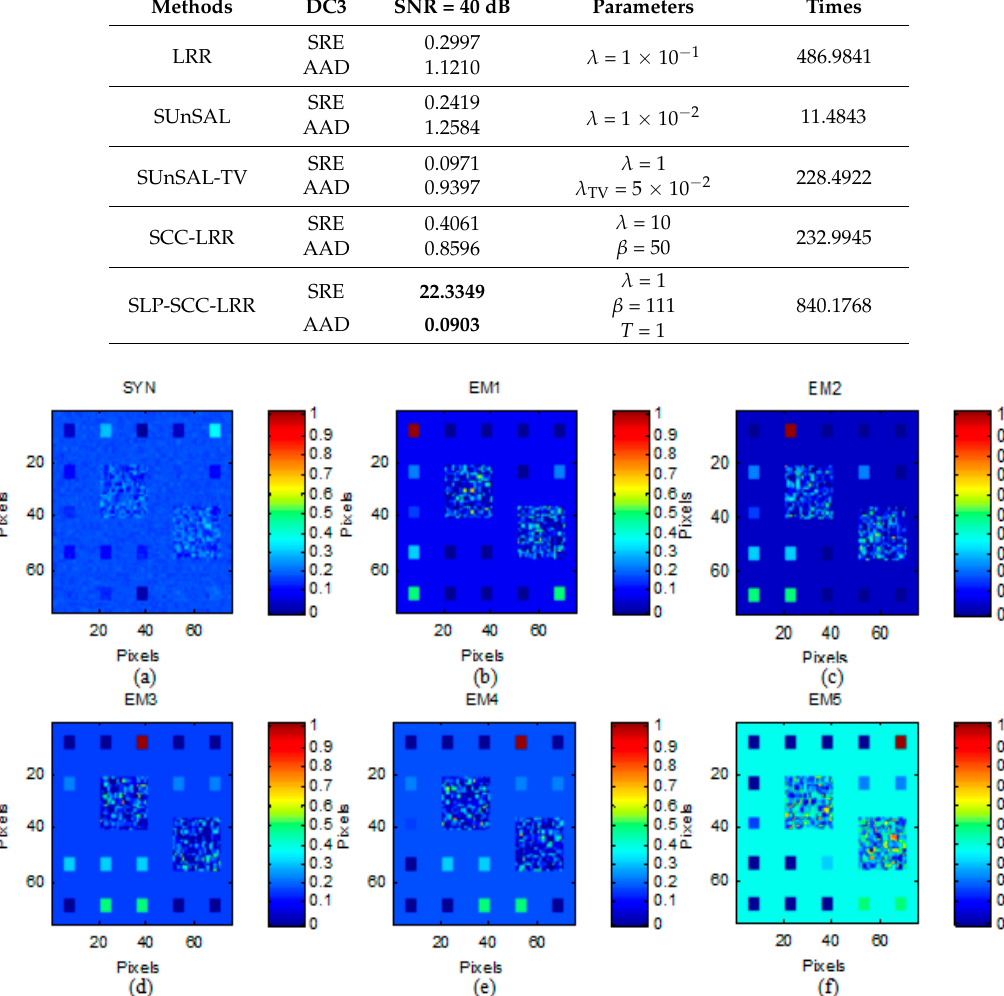
Figure 6. True fractional abundances of endmembers in the simulated data cube 3 (DC3): ( a ) simulated image; ( b ) the true abundance of endmember 1; ( c ) the true abundance of endmember 2; ( d ) the true abundance of endmember 3; ( e ) the true abundance of endmember 4; and ( f ) the true abundance of endmember 5.